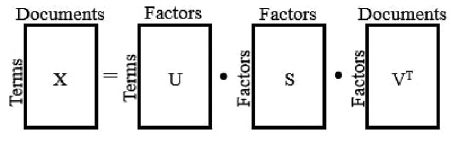
Figure 1. SVD in the context of the LSA